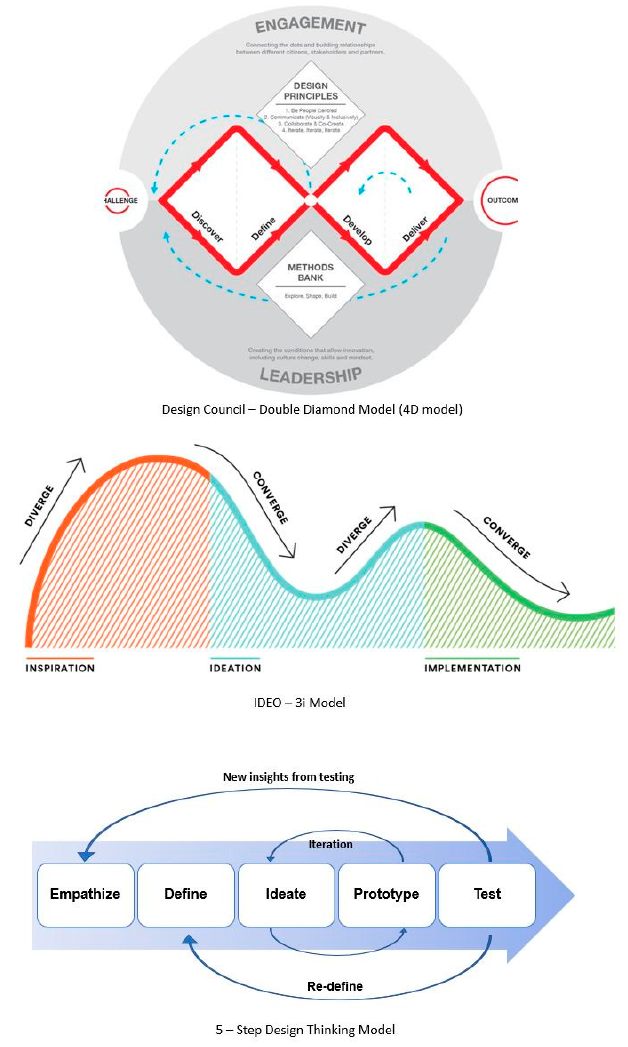
Figure 2. Examples of the existing design thinking models—double diamond model [27] (Reproduced with permission from Design Council, Design Council Web, Published Online, 2021). 3I model [31] (Re-produced with permission from IDEO, IDEO.org, Published Online, 2021.), and d.school 5- step model .